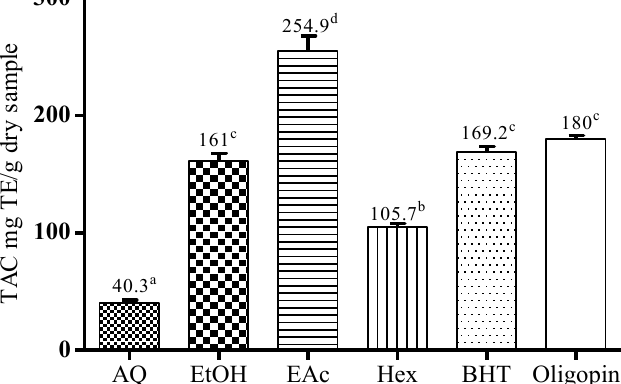
Figure 2. Total antioxidant capacity of M. arboreus AQ extract, EtOH extract and its fractions. The extracts having the same letter present no significant differences ( p < 0.05) according to Tukey statistical